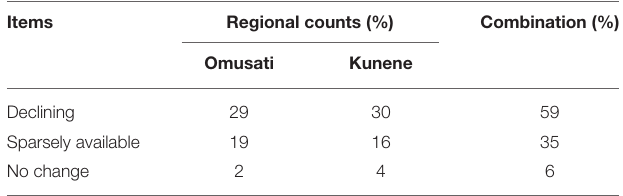
TABLE 2 | status of EVM plant species.